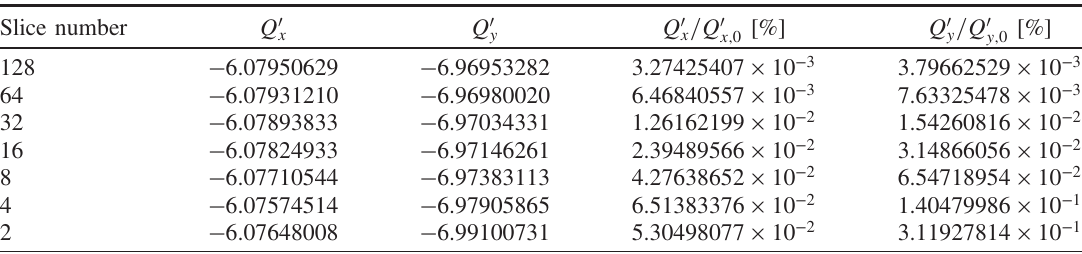
TABLE I. Simulated chromaticity in the PS for various slice